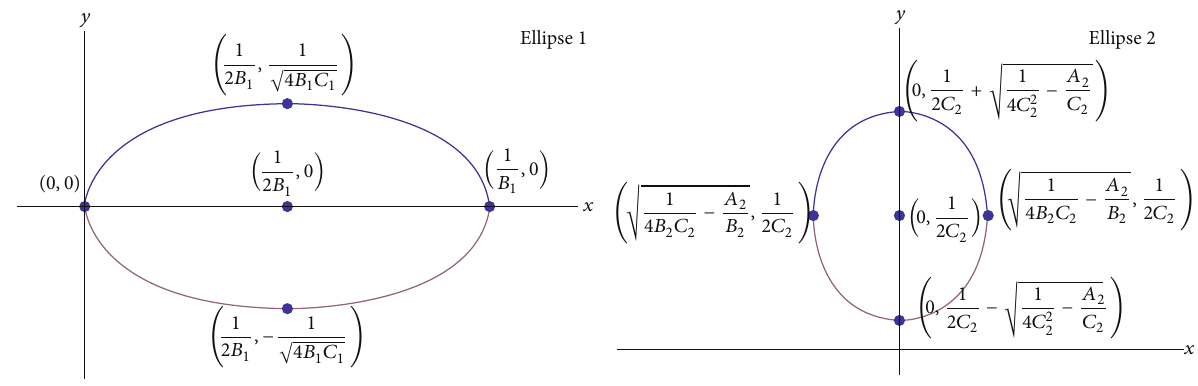
Figure 1: The equilibrium curves of system